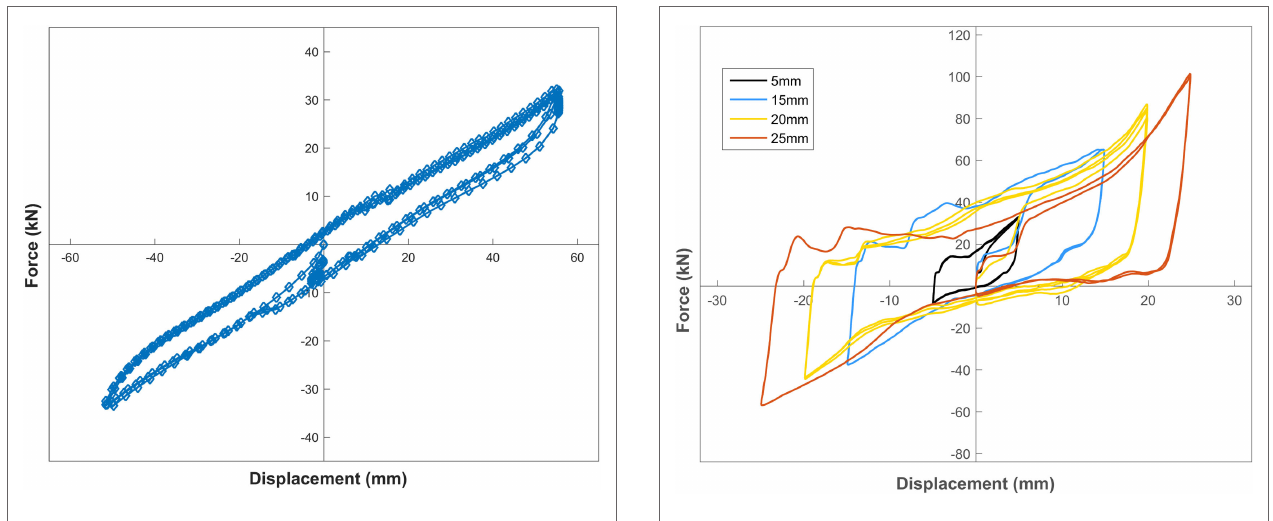
FigUre 8 | hysteresis loops under 0.5 hz frequency and different amplitudes of the sinusoidal excitation .